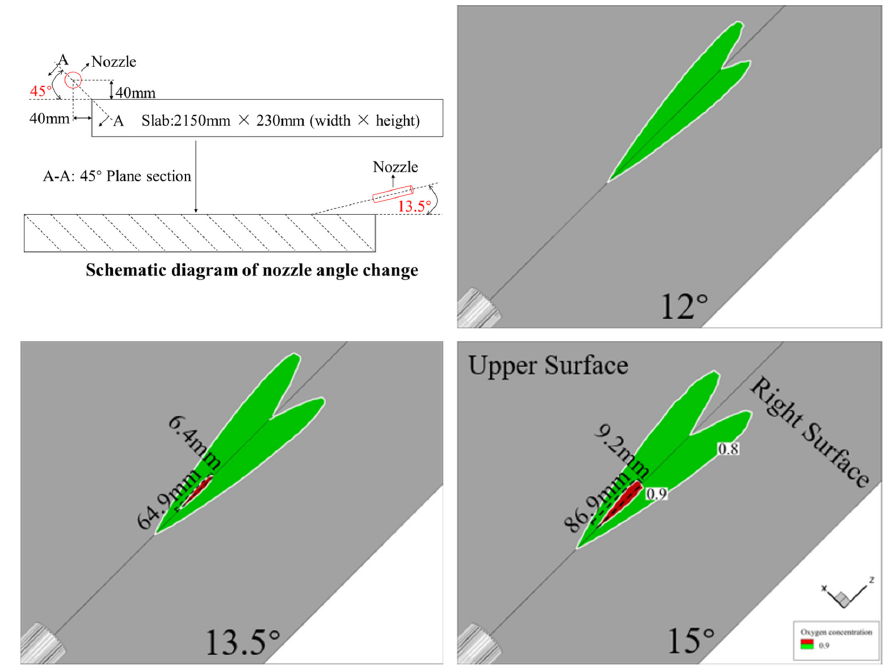
Figure 9. Oxygen concentration distribution of the casting slab surface.